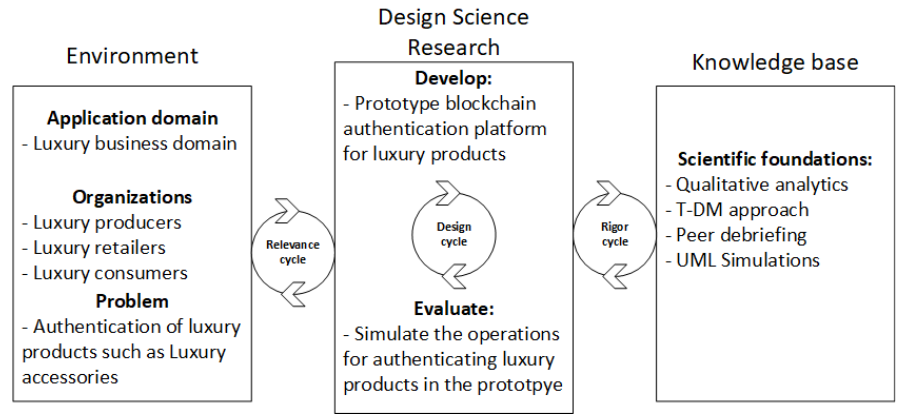
Figure 1. Instantiation of design science research method, adapted from [25].